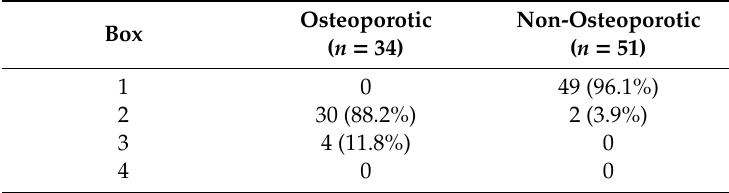
Table 1. Degree of bulging in both groups.